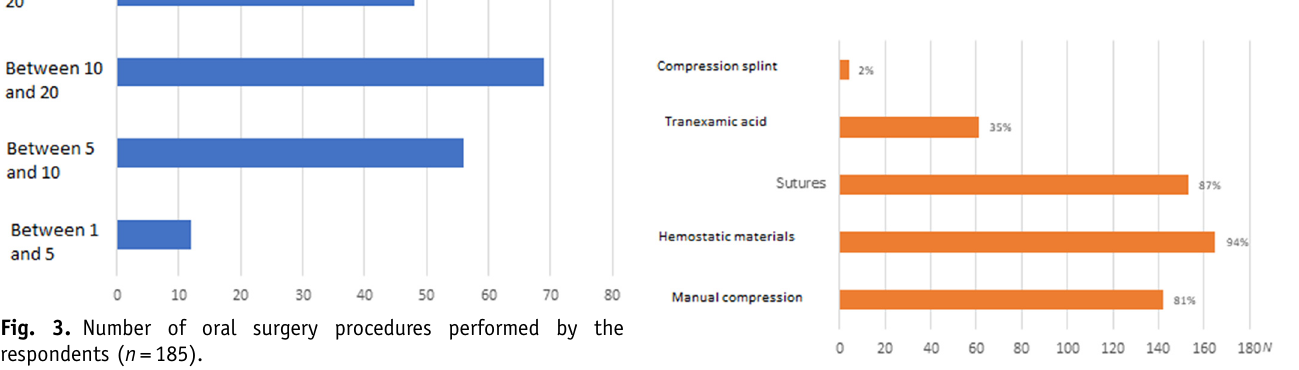
Fig. 5. Local hemostatic methods used by the respondents.